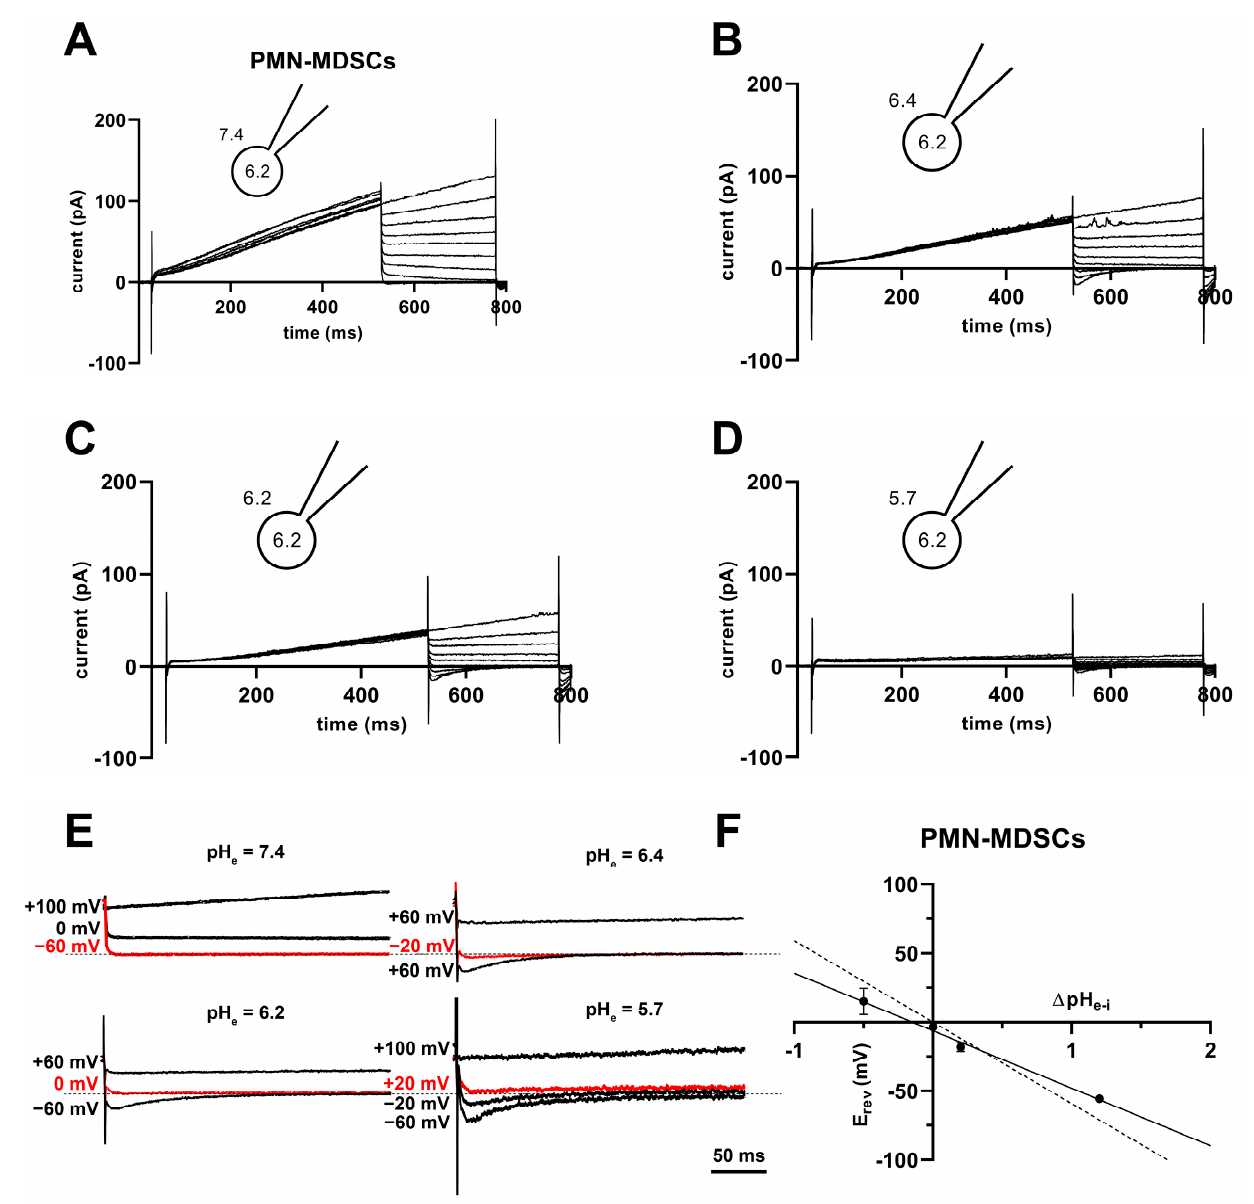
Figure 10. Tail currents and E rev in PMN-MDSCs. ( A – D ) Representative families of currents obtained using the tail current protocol in a PMN-MDSC cell. The cell was depolarized from a holding potential of − 80 mV to +100 mV for 500 ms followed by repolarizations to various potentials (from − 60 to +100 mV in 20 mV increments). The pH of the internal solution was maintained pH i = 6.2, and the cell was locally perfused with solutions having different pH e of 7.4 ( A ), 6.4 ( B ), 6.2 ( C ) and 5.7 ( D ). ( E ) Selected tail currents from ( A – D ) are illustrated at increased time and amplitude resolution. The tail currents corresponding to E rev are indicated in red. The dashed lines correspond to 0 pA current. ( F ) The reversal potentials (E rev ) were determined individually for each cell at each Δ pH e–i , averaged (mean ± SEM, 7.4: n = 18, 6.4: n = 11, 6.2: n = 11, 5.7: n = 4), and plotted as a function of Δ pH e–i . The best fit linear regression (solid line, slope: − 41.8 mV/ Δ pH, R 2 = 0.99) and the theoretical relationship calculated from the Nernst equation for H + (dashed line, slope: − 59.2 mV/ Δ pH) are indicated.